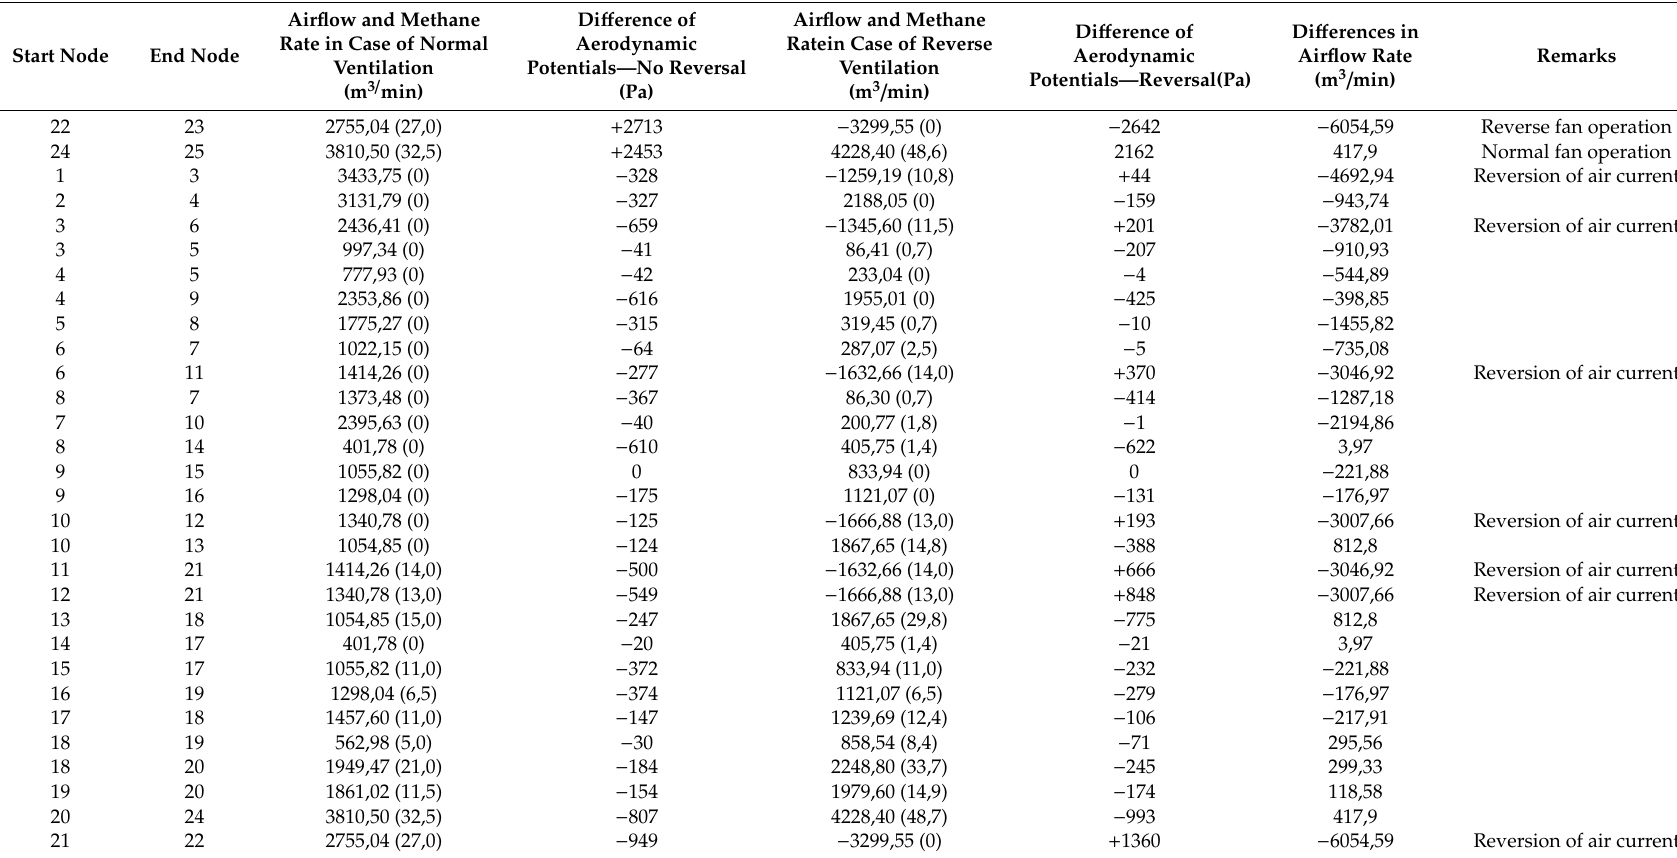
Table 2. Comparison of air and methane distribution in the ventilation network of mine A in the case of normal and reverse ventilation (own